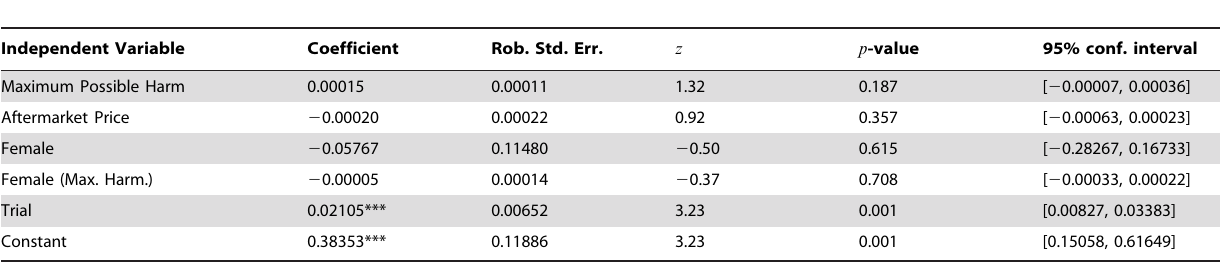
Table 1. Random effects estimation of relative spitefulness S i , t